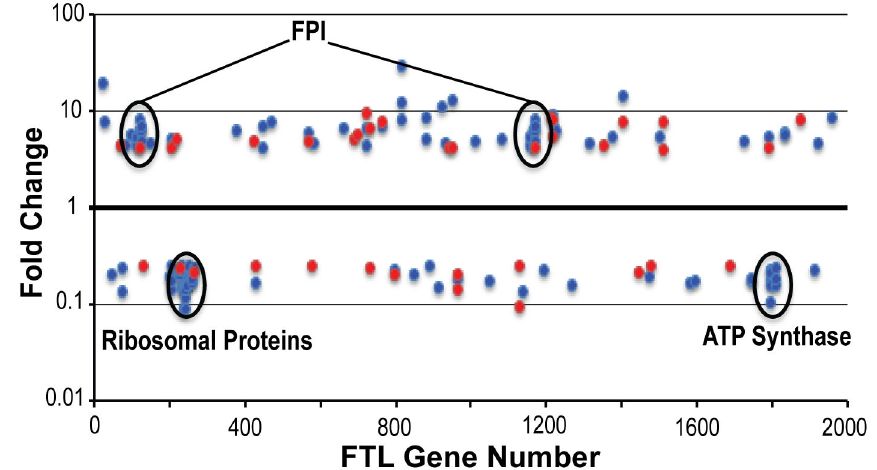
Figure 3. Differentially expressed genes plotted across the F. tularensis genome. All genes that had at least a 4-fold change in expression at either 4 hours (red) or 8 hours (blue) were plotted according to their gene ID number across the genome. The two copies of the FPI are highlighted in the up-regulated portion of the figure, and the ribosomal proteins and ATP synthase subunits are highlighted in the down-regulated portion of the